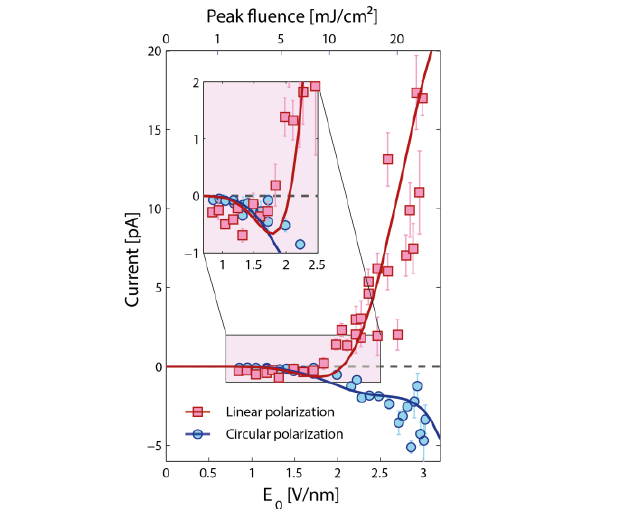
Fig. 2. Experimentally obtained CEP-dependent currents are plotted with red squares (linear polarization) and blue circles (circular polarization) as a function of the optical peak field strength. Inset indicates a reversal of the current direction at around 2 V/nm. c, Simulation showing, the conduction band population for each k-point as a function of the electric field strength after the pulse is